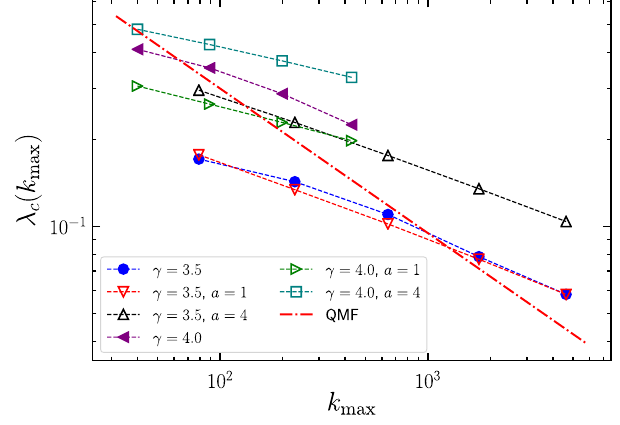
FIG. 6. Comparison between the theoretical finite-size thresh- old (for two different values of a ) (hollow symbols) and direct numerical simulations (full symbols) of the SIS process in UCM 3 ) and γ ¼ 4 networks with degree exponent γ ¼ 3 . 5 ( k min ¼ 2 ) [24]. The epidemic threshold is determined by means ( k min ¼ of the lifespan method [24]. The dashed red line is proportional to ffiffiffiffiffiffiffiffiffi p k the prediction 1 = of the QMF theory. The values of k max max correspond to sizes ranging from N ¼ 10 4 to N ¼ 10 8 for γ ¼ 3 . 5 and from N ¼ 10 4 to N ¼ 10 7 for γ ¼ 4